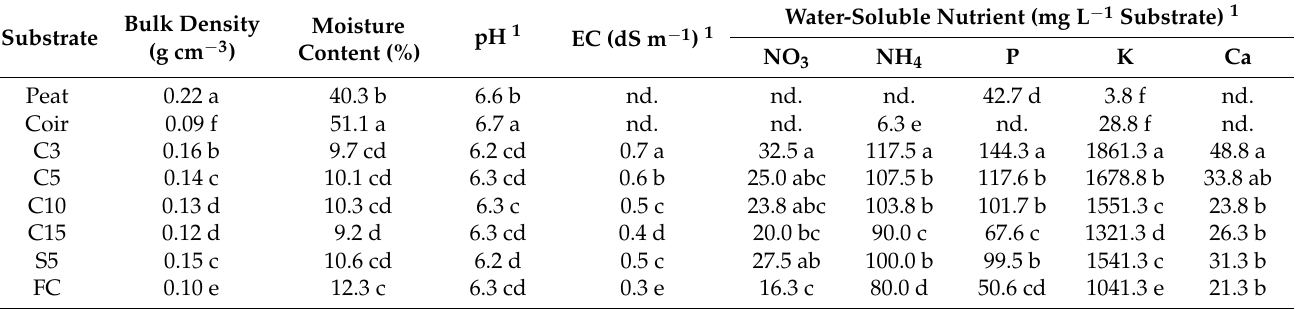
Table 3. Bulk density, moisture content, pH, electrical conductivity (EC), and water-soluble of nutrients of peat, coir, and processed miscanthus